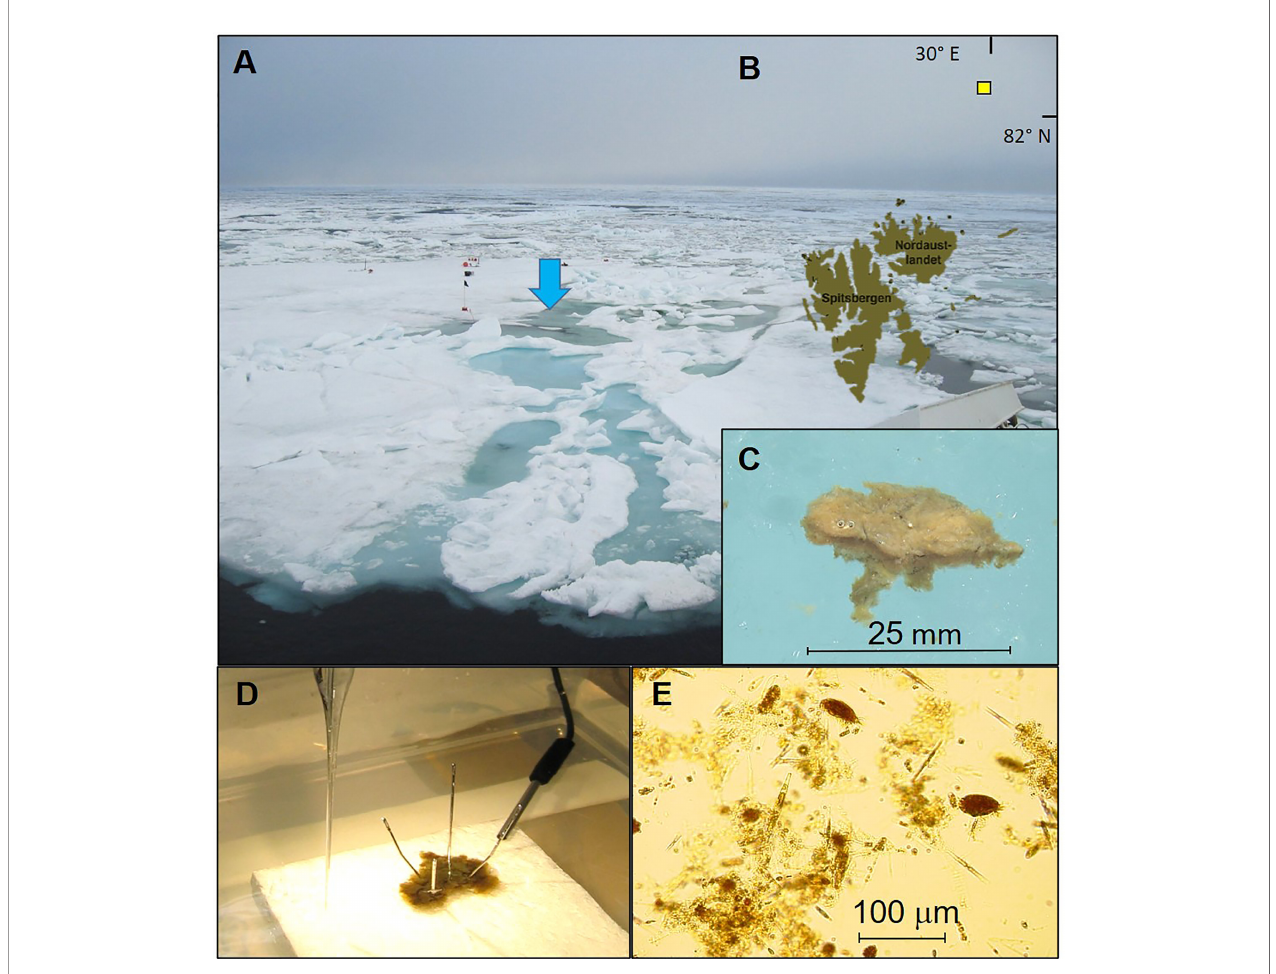
FIGURE 1 | Ice fl oe at the sampling site where the ice algal mats were collected (marked with blue arrow) with open and closed melt ponds (A) , and the sampling position at N 82° 24.9 marked with a yellow square in (B) to the NE of Svalbard. Close up of the sampled algal material that was recognized as brown-colored coherent mats with a clearly layered structure (C) . The mats were initially between 3 and 10 cm wide but broke up in smaller pieces (1-3 cm across) during sampling and transport to the lab onboard the research vessel. An experimental setup with controlled temperature and light conditions were established to measure gross and net O 2 production in the mats (D) , that consisted of a complex community of microalgae and diverse grazers including ciliates (E) . Photos by the authors (K.